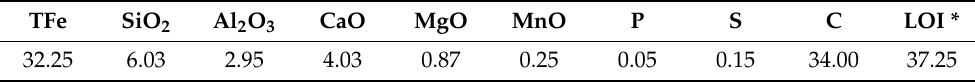
Table 1. The main chemical composition of BF dust, wt.%.